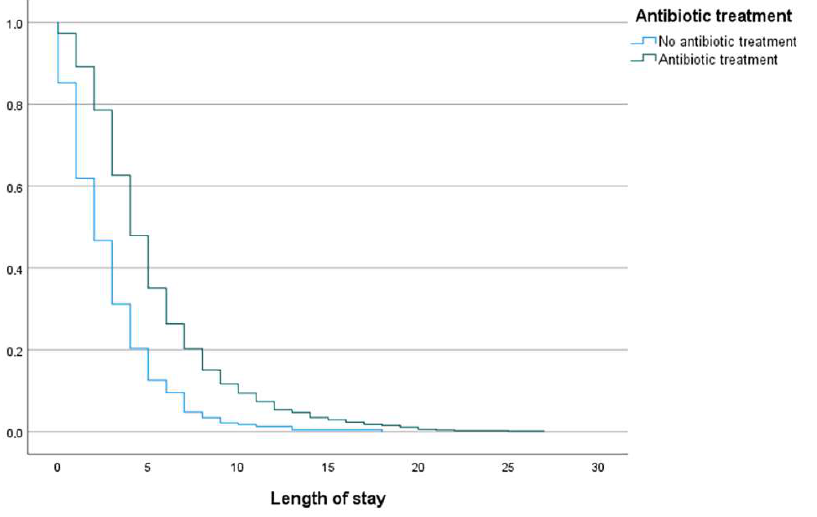
Figure 2. Kaplan-Meier analysis on length of stay comparing the groups of patients according to antibiotic treatment.